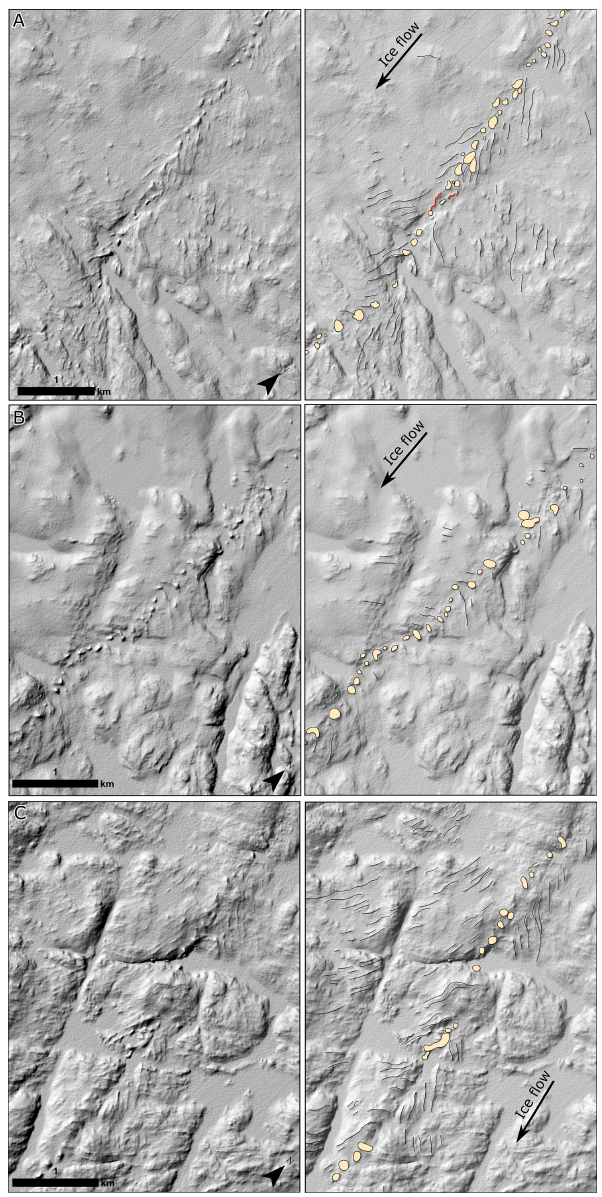
Figure 4. Relationship between esker beads and De Geer moraines. Right-hand column is the mapped (beads are yellow polygons; moraines are black lines; esker ridges are red lines) interpretation of (a) , (b) , and (c) . Note how the De Geer moraines typically form a V-shaped geometry pointing up-ice and the close association be- tween individual moraines and beads. In some cases (e.g. a ) the ridges originate from the beads. Locations are displayed in Fig. 1. DEMs created by the Polar Geospatial Center from DigitalGlobe, Inc.,